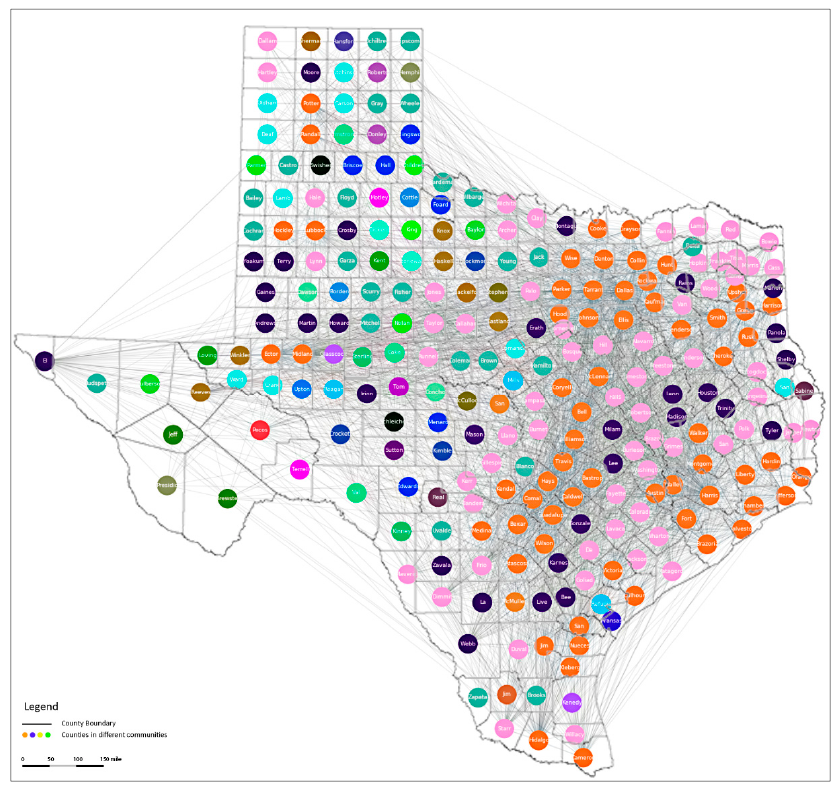
Figure 5. Communities Detected for Texas Counties.